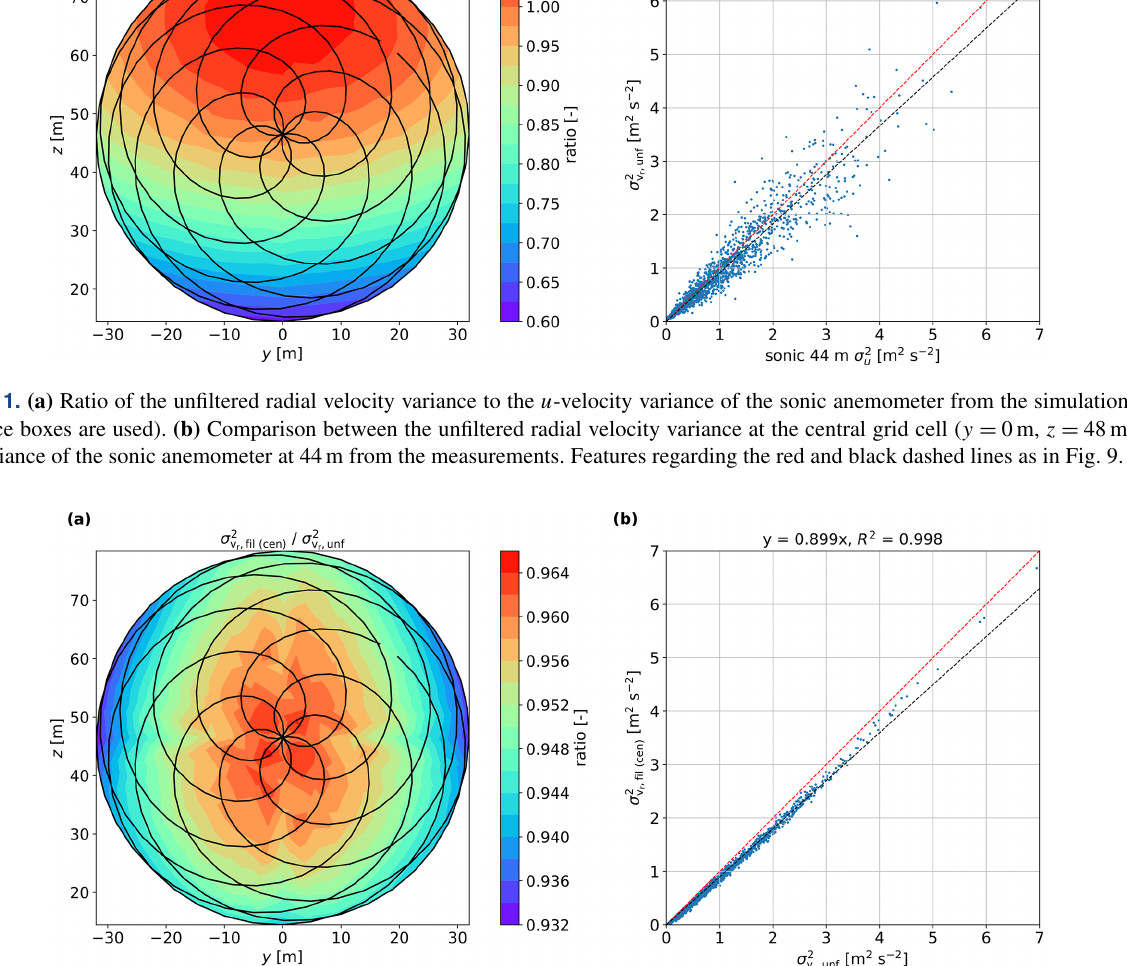
Figure 12. (a) Ratio of the filtered to the unfiltered radial velocity variance from simulations (30 turbulence boxes are used). (b) Comparison between the SpinnerLidar filtered and unfiltered radial velocity variance at the central grid cell ( y = 0m, z = 48m) from the measurements. Features regarding the red and black dashed lines as in Fig.